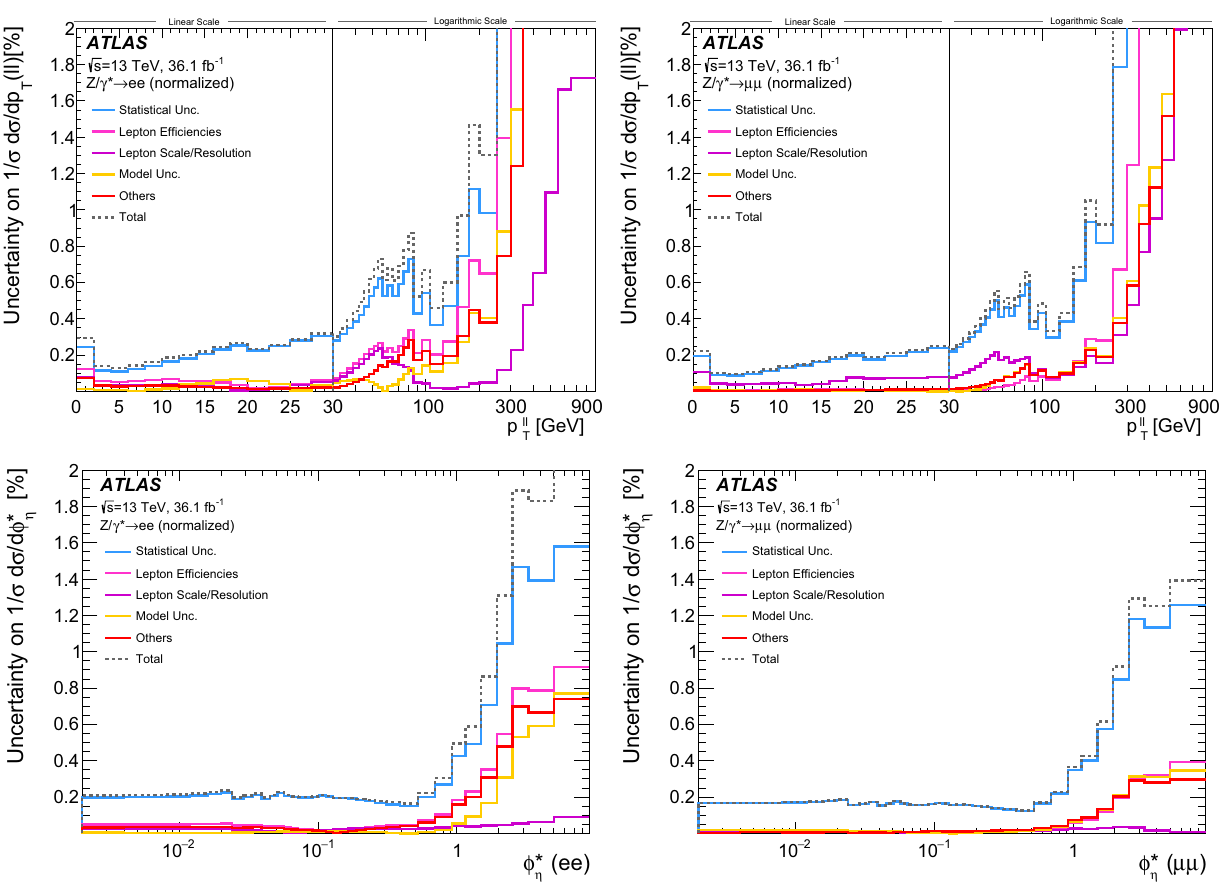
Fig. 3 The systematic uncertainties for the electron channel measure- ment (left) and muon channel measurement (right) for the normalized p (cid:3)(cid:3) (upper row) and normalized φ ∗ η (lower row). The statistical uncer- T tainties are a combination of the uncertainties due to limited data and